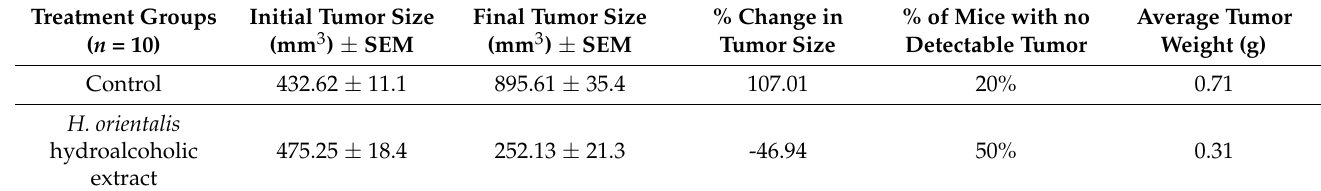
Table 6. Effect of H. orientalis L. hydroalcoholic extract on tumor size and cure percentage.